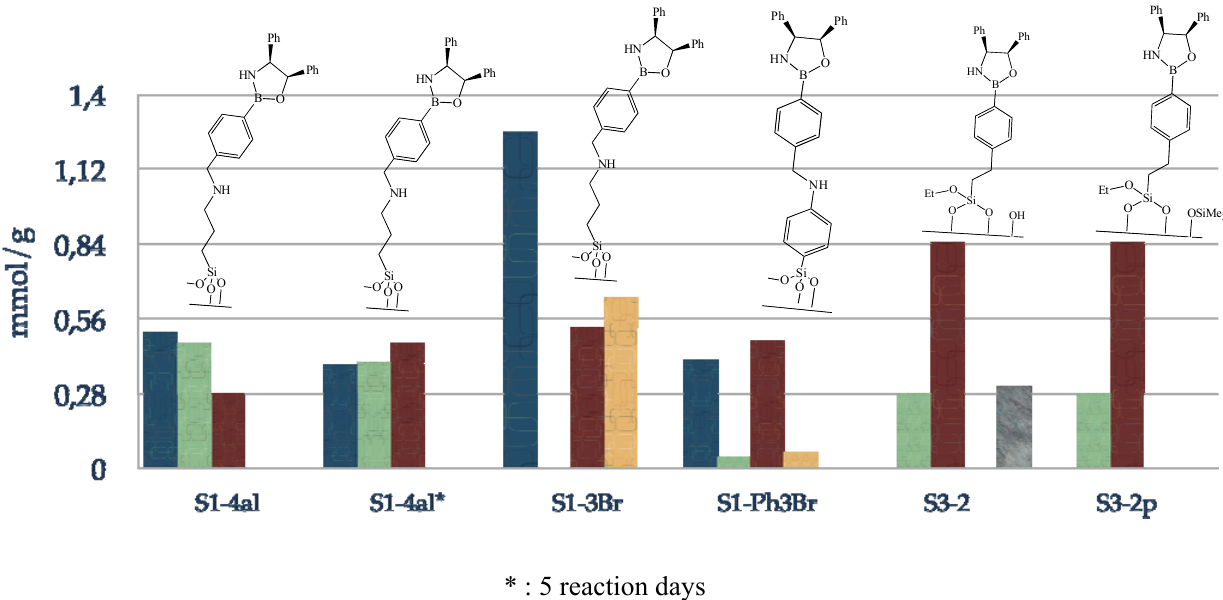
Figure 5. Composition of supported oxazaborolidine via boron substituent; blue: amino species, green: boronic acid species, red: immobilized oxazaborolidine, grey: physisorbed amino